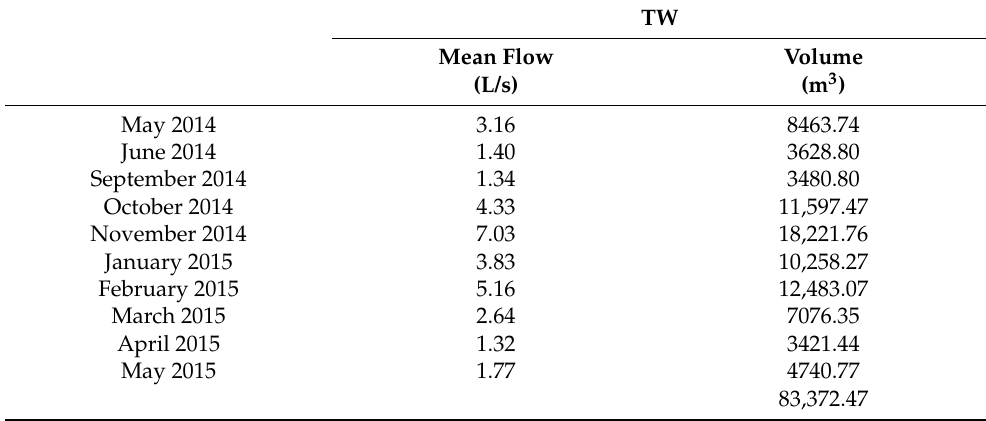
Table 1. Total waterflow (TW): mean monthly flow and corresponding total monthly volumes.